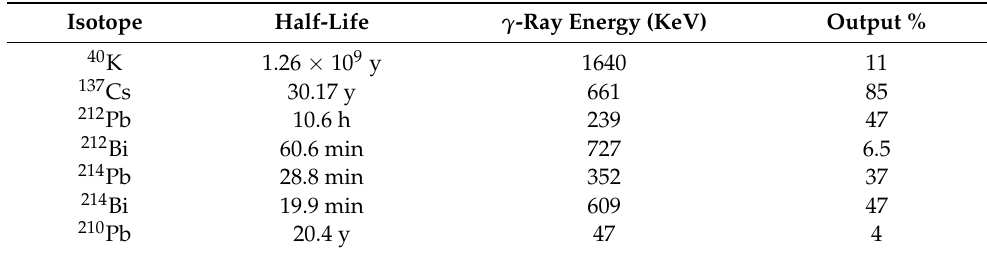
Table A2. The main characteristics of the gamma-ray-emitting isotopes utilized in this study.